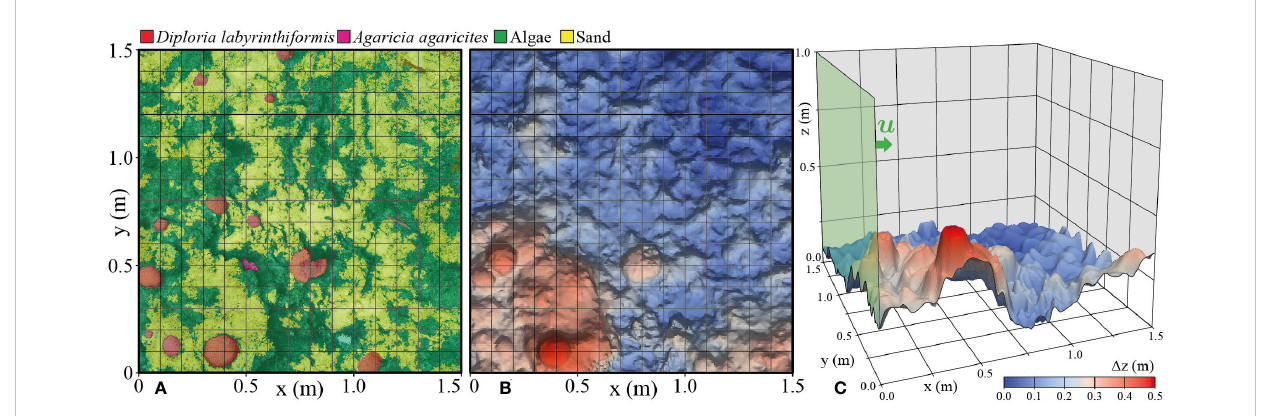
FIGURE 2 (A) Annotation of functional surface types in the reef ecosystem domain. (B) Bathymetry generated through the Structure from Motion method. (C) Domain geometry and the in fl ow